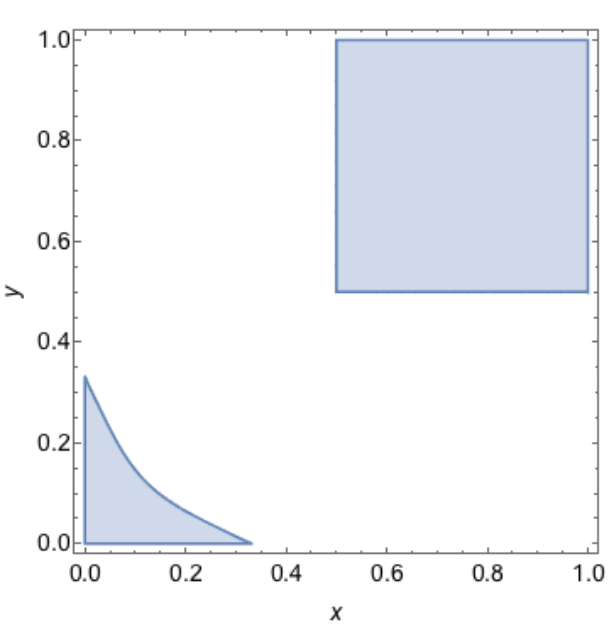
Figure 10. Stable QRE-achievable states for a coordination game with a Y > b Y . A point ( x , y ) represents a mixed strategy profile, where the first agent chooses its first strategy with probability x and the second agent chooses its first strategy with probability y . The grey areas depict the set of mixed strategy profiles ( x , y ) that can be reproduced as stable QRE states a coordination game with a Y > b Y , i.e., these are outcomes for which there are temperature parameters ( T x , T y ) for which the ( x , y ) mixed strategy profile is a stable